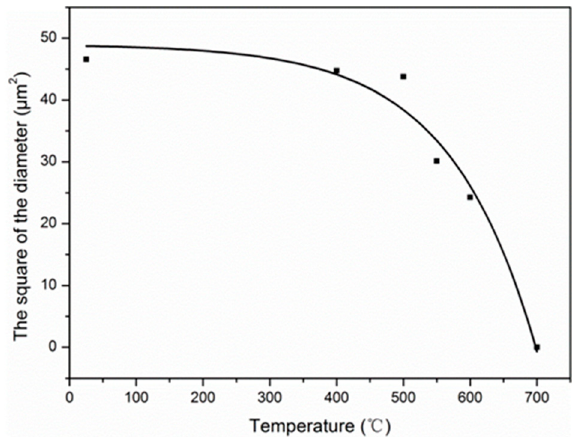
Figure 12. The effect of exposure temperature on the square of the diameter of carbon fibers.